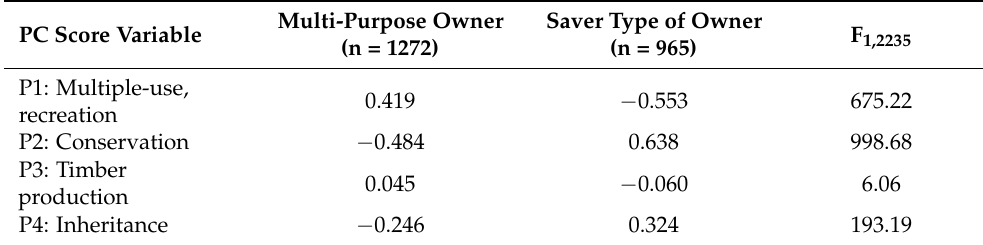
Table 4. Forest owner grouping based on the PC score variables on their objectives of forest ownership (n = 2237). F-values reveal the contribution of the PC score variables in the clustering. Multi-Purpose Owner PC Score Variable (n = 1272) recreation